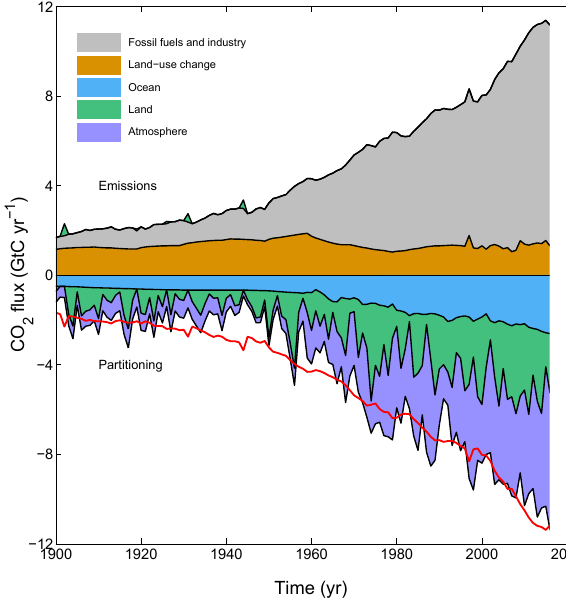
Figure 3. Combined components of the global carbon budget il- lustrated in Fig. 2 as a function of time, for emissions from fossil fuels and industry ( E FF ; grey) and emissions from land-use change ( E LUC ; brown), as well as their partitioning among the atmosphere ( G ATM ; purple), land ( S LAND ; green), and oceans ( S OCEAN ; blue). The partitioning is based on nearly independent estimates from ob- servations (for G ATM ) and from process model ensembles con- strained by data (for S OCEAN and S LAND ) and does not exactly add up to the sum of the emissions, resulting in a budget imbal- ance which is represented by the difference between the bottom red line (reflecting total emissions) and the sum of the ocean, land, and atmosphere. All time series are in GtCyr − 1 . G ATM and S OCEAN prior to 1959 are based on different methods. E FF is primarily from Boden et al. (2017) with uncertainty of about ± 5% ( ± 1 σ ); E LUC are from two bookkeeping models (Table 2) with uncertainties of about ± 50%; G ATM prior to 1959 is from Joos and Spahni (2008) with uncertainties equivalent to about ± 0.1–0.15GtCyr − 1 , and from Dlugokencky and Tans (2018) from 1959 with uncertainties of about ± 0.2GtCyr − 1 ; S OCEAN prior to 1959 is averaged from Khatiwala et al. (2013) and DeVries (2014) with uncertainty of about ± 30%, and from a multi-model mean (Table 4) from 1959 with uncertainties of about ± 0.5GtCyr − 1 ; S LAND is a multi-model mean (Table 4) with uncertainties of about ± 0.9GtCyr − 1 . See the text for more details of each component and their